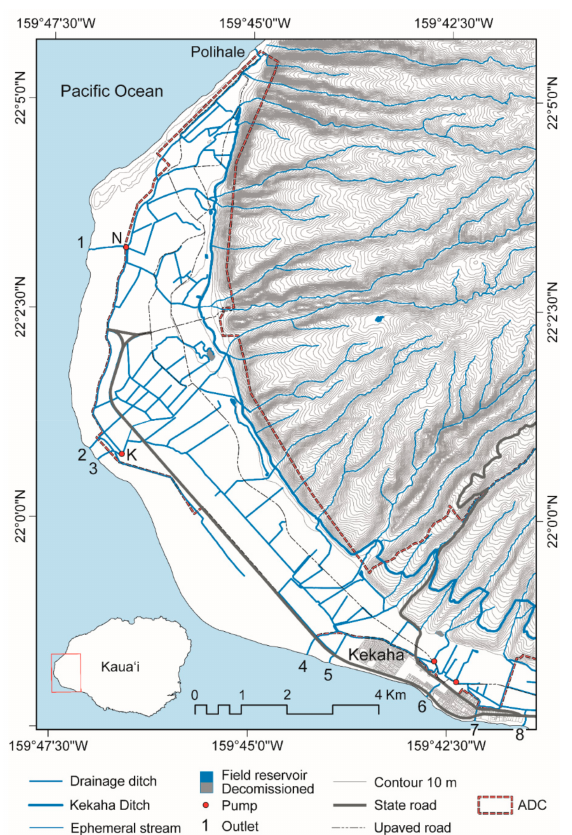
Figure 2. Hydrography of the M¯an¯a Plain and Pu‘u Ka Pele Slope (see text for discussion). Contour interval 10 m (cf. Figure 1). K and N indicate the location of the main pumping station at Kawai‘ele and the inoperative pumps at Nohili. The location of two booster pumps on the ditch system near Kekaha is also shown. Numbers (1–8) indicate the location of the drainage ditch system’s outlets: 1, Nohili Ditch; 2, Kinikini Ditch; 3, Dry Ditch; 4, Second Ditch; 5, First Ditch; 6, Mill Drain; 7, Cox Drain; 8, K¯ık¯ıa‘ola Harbor Drain. The boundary of the State of Hawai‘i Agribusiness Development Corporation’s (ADC) land facilitates comparison with Figures 3 and